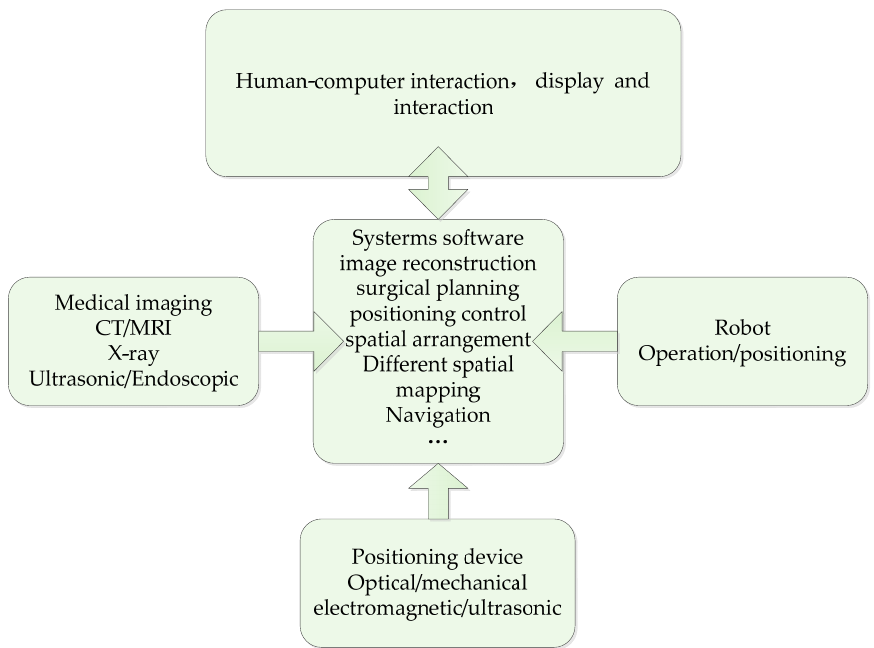
Figure 7. Function distribution diagram of rehabilitation robots.